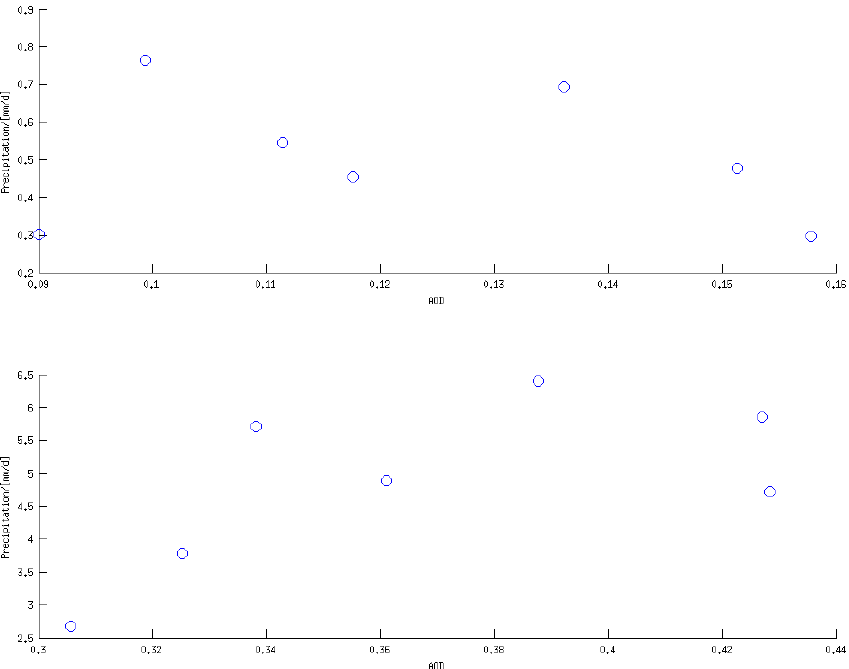
Figure 15. Values of mean AOD and mean precipitation for separate years in the area 65–90 ◦ E, 20–35 ◦ N in April (above) and July (below), MAIN_ACT